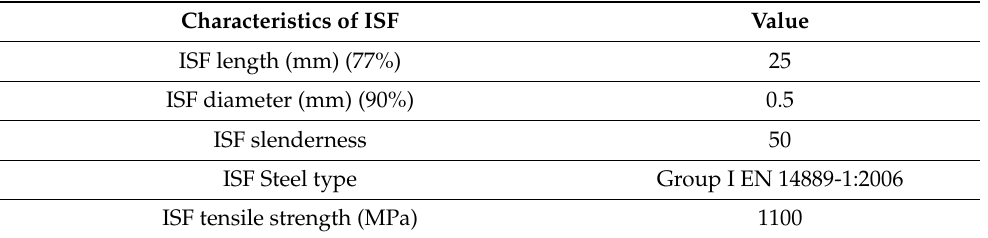
Table 2. Mechanical and geometrical features of ISF (according to the producer’s declaration).